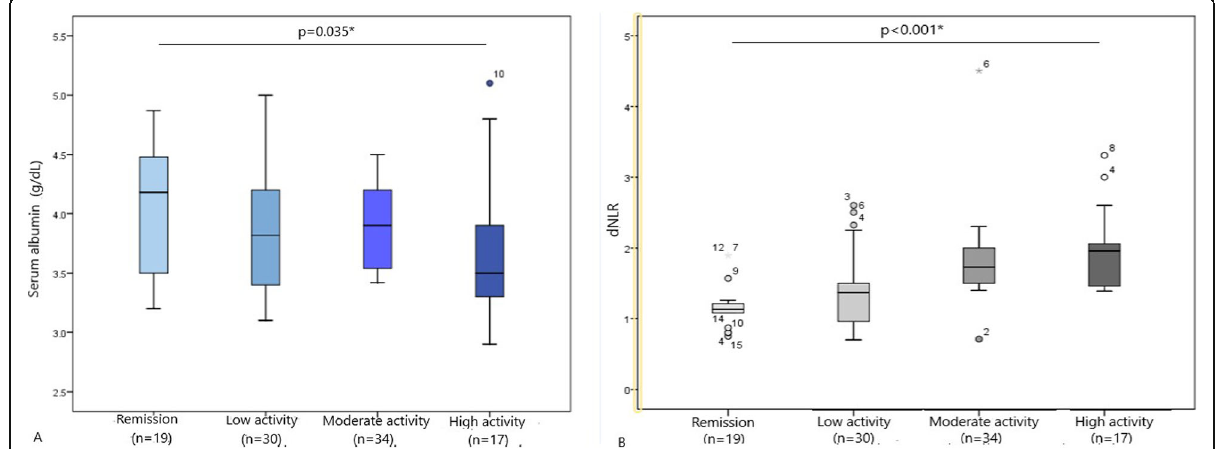
Fig. 2 Comparison of serum albumin levels ( a ) and dNLR ( b ) according to different disease activity grades as assessed by DAS28 in rheumatoid arthritis patients. dNLR, derived neutrophil-to-lymphocyte ratio; DAS, disease activity score. *significant at p < 0.05